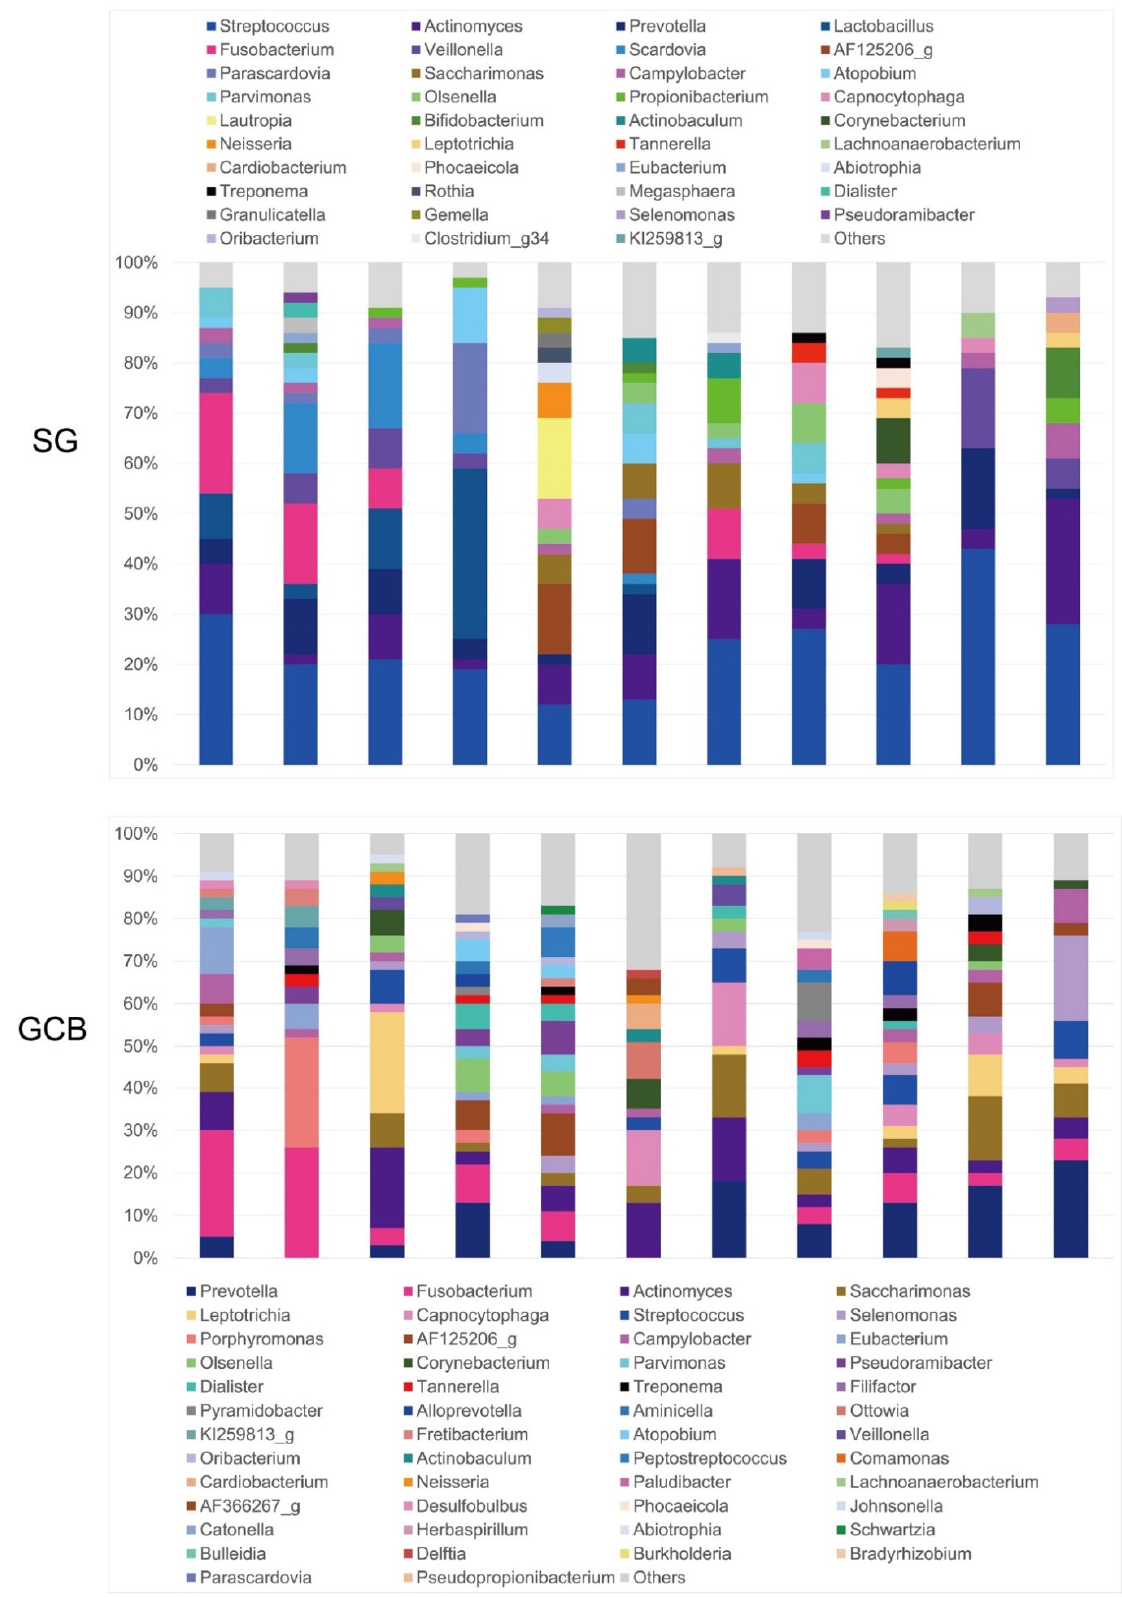
Figure 4. Relative abundance of major bacterial genera. Sequence data for determining the genera in the SG and GCB are obtained from 11 individual root caries lesions. SG: root caries that existed independently above the gingival margin, GCB: root caries that progressed below the gingival margin.